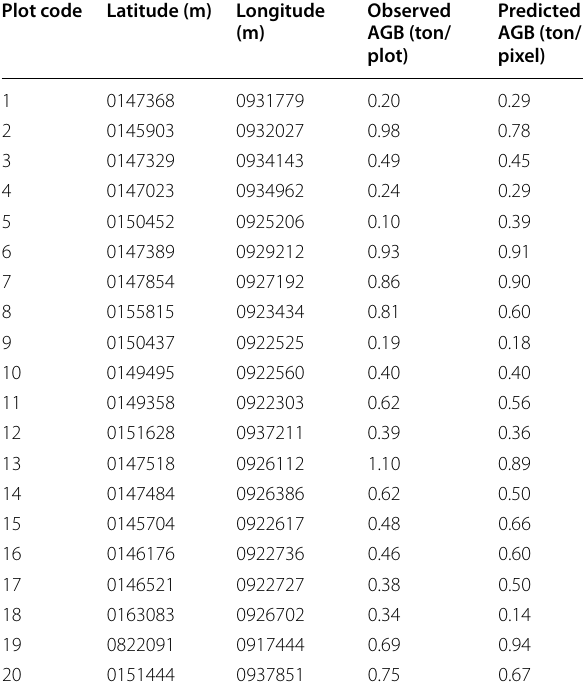
Table 8 Values of the observed and predicted above-ground biomass Plot code Latitude (m) Longitude